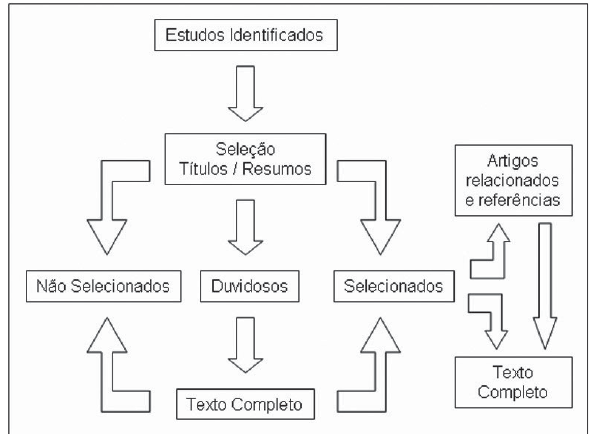
Fig. 2 - Fluxograma da seleção dos